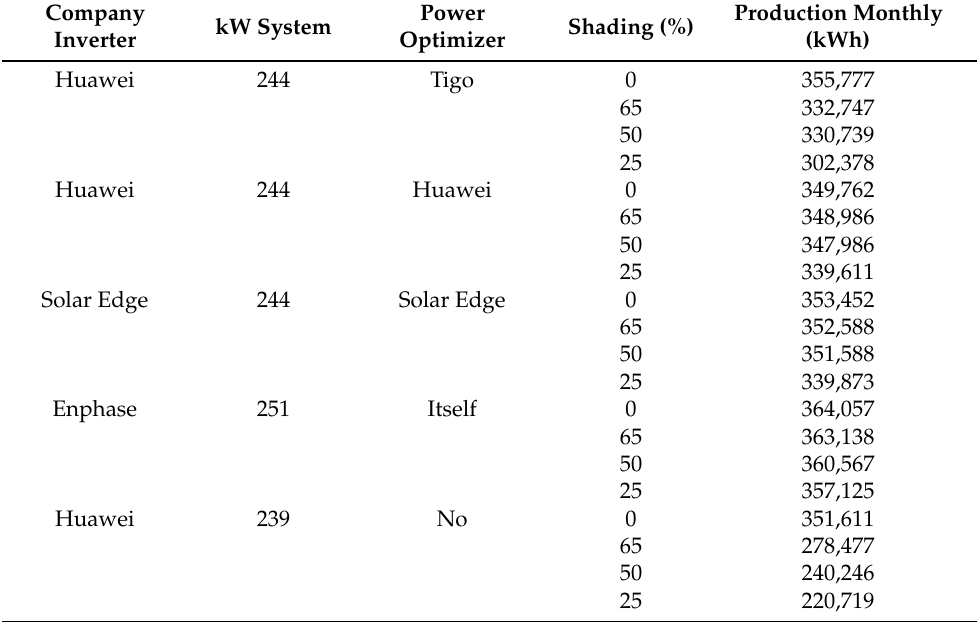
Table 6. Comparison table for the Simulink